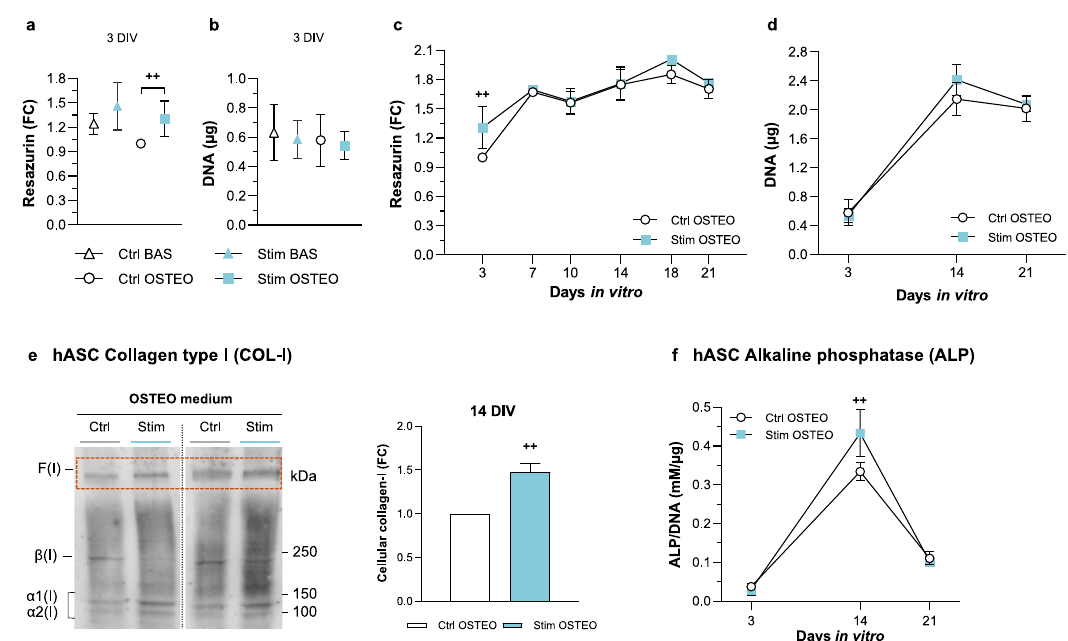
Fig. 5 High frequency stimuli impacts on metabolism, proliferation, and osteogenic markers of human adipose-derived mesenchymal stem cells (hASCs). Early response of cells cultured for 3 DIV in BASAL or OSTEO medium and under Ctrl or Stim conditions, regarding a cellular metabolism ( n = 9) and b DNA content ( n = 3). Time-dependent pro fi les of cells ’ c metabolic activity ( n = 9 – 17) and d DNA content ( n = 3 – 4), when cultured for 3 – 21 DIV in OSTEO medium and under Ctrl or Stim conditions. Fold changes were calculated over Ctrl OSTEO values at the initial time point (3 DIV). e Immunoblot analysis and relative quanti fi cation of cellular collagen-I (COL-I) levels. α 1(I) and α 2(I) monomeric chains, β (I), dimeric forms and F(I), collagen fi brils. Molecular weights are indicated to the right. DIV, days in vitro. Fold changes were calculated over Ctrl condition. f Alkaline phosphatase (ALP) quanti fi cation under Ctrl and Stim conditions (n = 3 – 4). Data were normalized to DNA content. Statistic symbols: ( + ) Ctrl vs Stim conditions; ++ P <